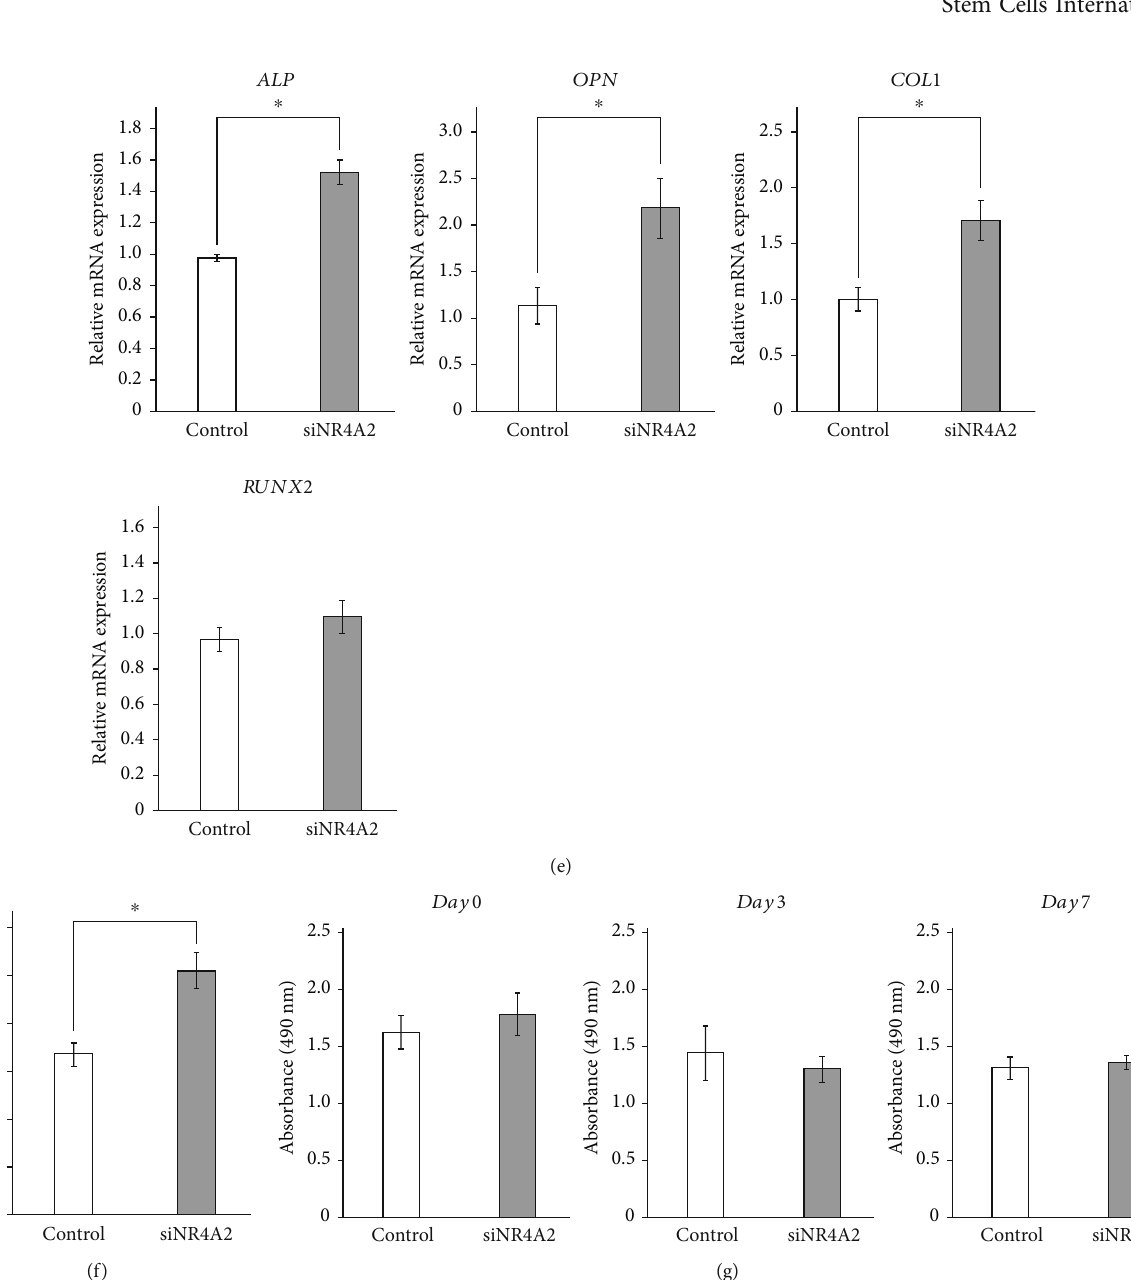
Figure 4: Enhancement of osteogenesis in hPDLMSC spheroid treated with NR4A2 siRNA through ALP activation. (a, b) Con fi rmation of silencing of NR4A2 by siRNA in spheroid-cultured hPDLMSC. NR4A2 siRNA decreased mRNA expression of NR4A2 to about 30%. Expression of NR4A2 also was reduced by siNR4A2. (c) E ff ects of siNR4A2 on OCT4 , NANOG , and SOD2 mRNA expression in spheroid hPDLMSCs. The expression of OCT4 , NANOG , and SOD2 mRNA was examined by real-time RT-PCR. ∗ p < 0 : 05 (compared with control). (d) Nodule formation of hPDLMSC spheroid treated with siNR4A2 or control in OIM condition. Cells were transfected with siNR4A2 or control and then cultured for 12 days in osteoinductive medium and stained with alizarin red. (e) E ff ects of siNR4A2 on ALP, OPN, Col1, and RUNX2 mRNA expression in spheroid hPDLMSCs cultured with OIM. On day 7, the expression of ALP, OPN, Col1, and RUNX2 mRNA was examined by real-time RT-PCR. ∗ p < 0 : 05 (compared with control). (f) E ff ects of siNR4A2 on ALP activity in spheroid hPDLMSCs cultured with OIM. On day 7, ALP activity was measured. ∗ p < 0 : 05 (compared with control). (g) E ff ect of siNR4A2 on proliferation in spheroid hPDLMSCs on days 0, 3, and 7. All experiments were performed with samples from four